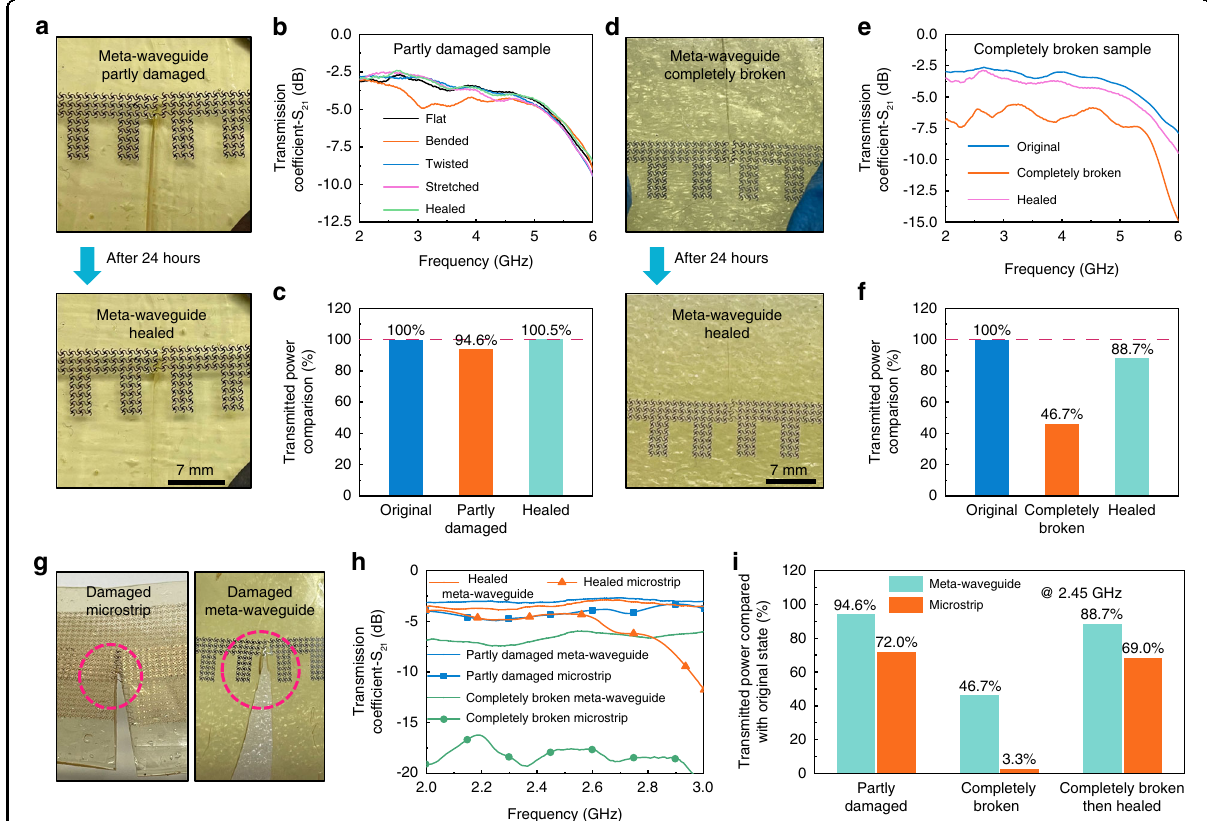
Fig. 5 Damage resistance and self-healing performance of the spoof plasmonic meta-waveguide sample. a Photograph of the partly damaged and healed sample. b Measured transmission coef fi cients of the damaged sample. c Transmitted power comparison between the damaged sample and healed sample. d Photograph of the completely broken and healed sample. e Measured transmission coef fi cients of the completely broken sample. f Transmitted power comparison between the broken sample and healed sample. g Damage resistance experiment between the proposed meta-waveguide and microstrip line. h , i Transmission comparison between the proposed meta-waveguide and